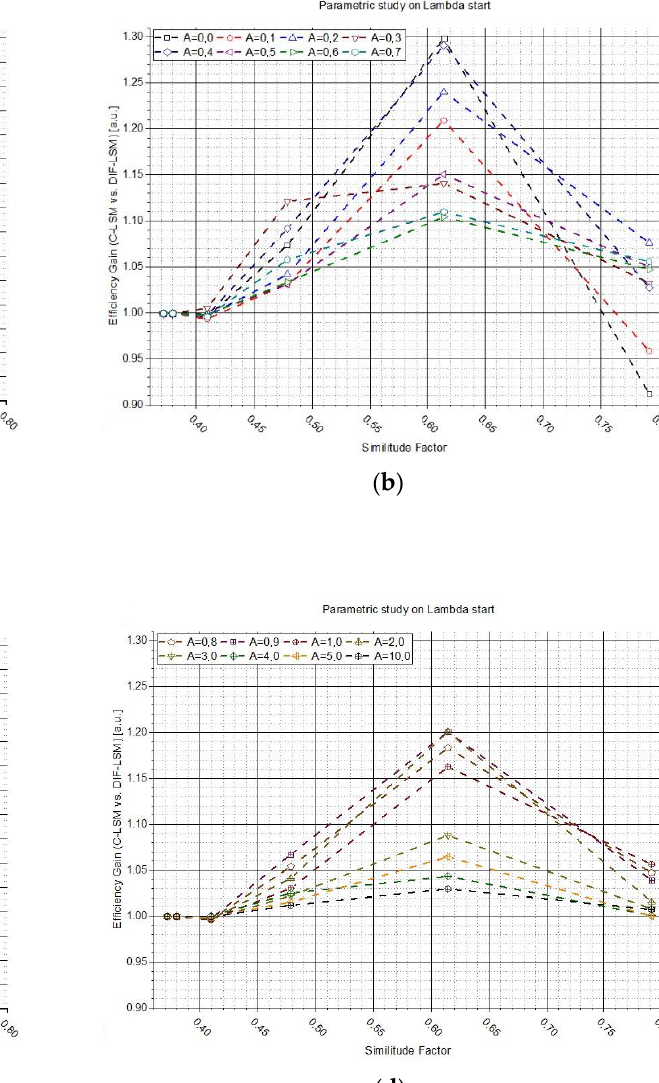
Figure 4. Influence of the similitude factor on the W DIF -LSM algorithm. Figure ( a – c ) shows the efficiency gain results ( G ) between the two algorithms as a function of the similitude factor ( f sim ) obtained from the parametric study on σ . Figure ( b – d ) shows the efficiency gain results ( G ), for the parametric study on λ s , which is reported as a function of the relative variation of the similitude factor ( f sim ). Every test was conducted varying parameter A